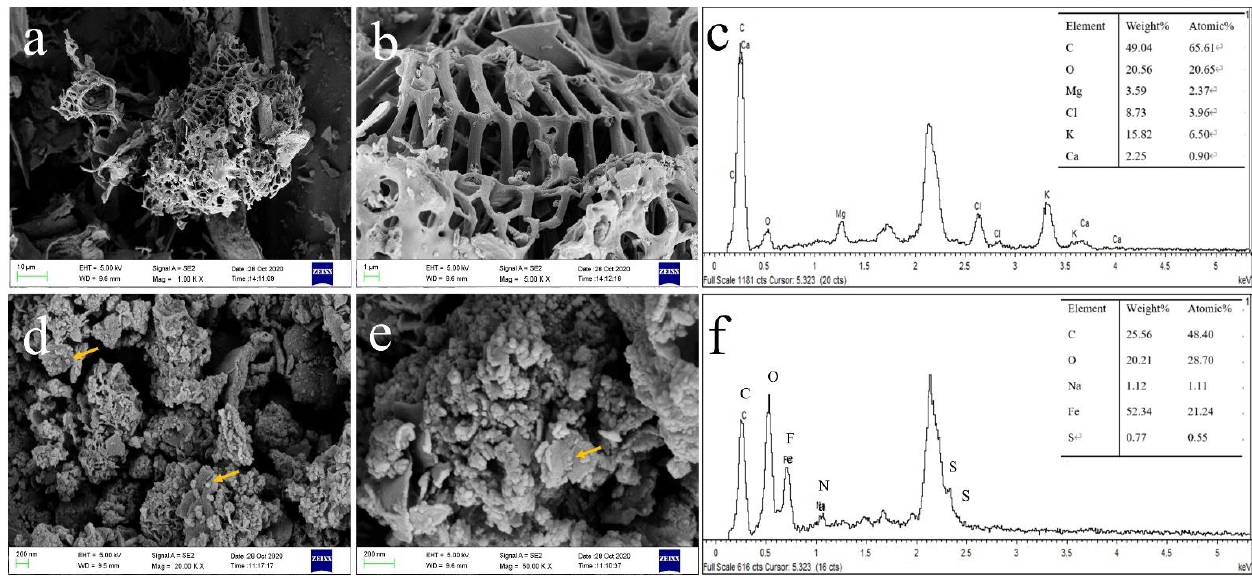
Figure 2. The SEM images of ( a , b ) BC and ( d , e ) BC-SnZVI; the EDS survey for ( c ) BC and ( f ) BC-SnZVI. ( f )